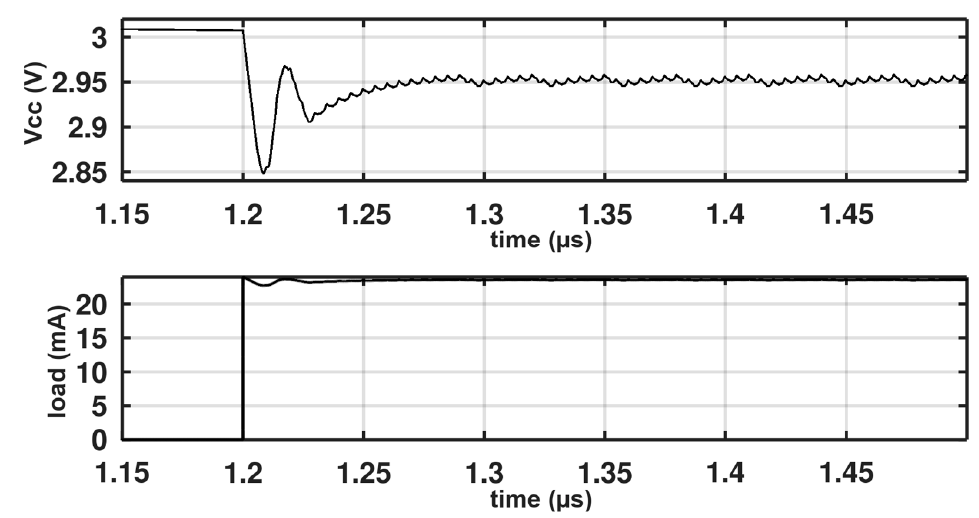
Figure 15. Transient response of the regulator when the load changes from 0 to ~24 mA in 100 ps.